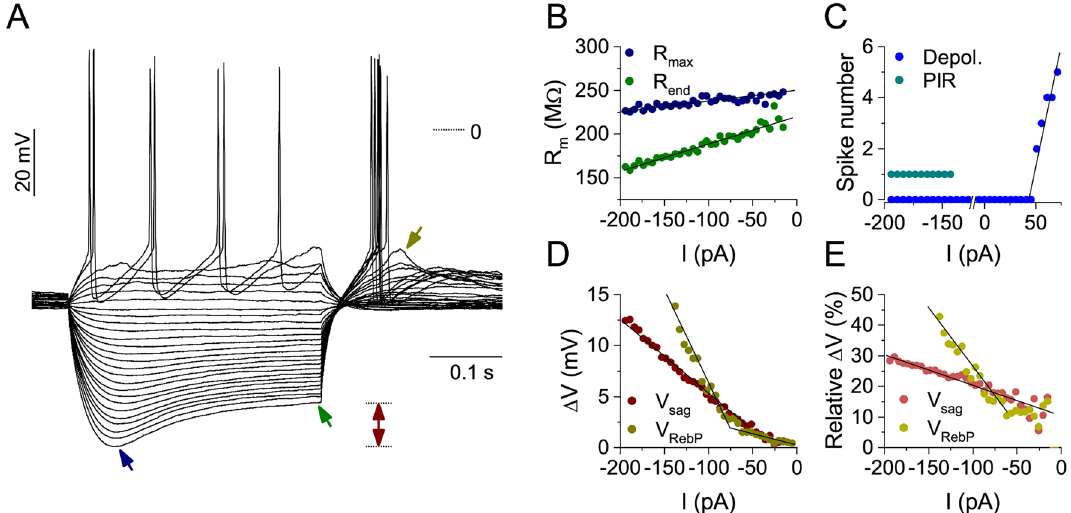
Figure 3. Analysis of the voltage responses of cultured hippocampal neurons under current step stimulation. The neuron exhibits voltage sag and post-inhibitory rebound firing under the injection of negative current steps ( A ). The maximal voltage deflection (blue arrow, ∆V max ) and the voltage at the end of the current pulse (green arrow, ∆V end ) are used to obtain the input resistance curves on ( B ) The spike number as a function of the input current is shown in ( C ) (I–O relationship; blue symbols for spikes under positive current steps, teal symbols for PIR spikes). Here the rheobase and the initial slope of the I–O curve (gain) are determined. Voltage sag (maroon) and rebound potential (RebP; dark yellow) as functions of the input current are shown in ( D ) RebP in this cell grows steeply when current pulses more negative than − 100 pA are injected. ( E ) shows the relative voltage sag and relative RebP from the same data. These are calculated by dividing voltage sag and RebP values by their corresponding maximal voltage deflection values (∆V max